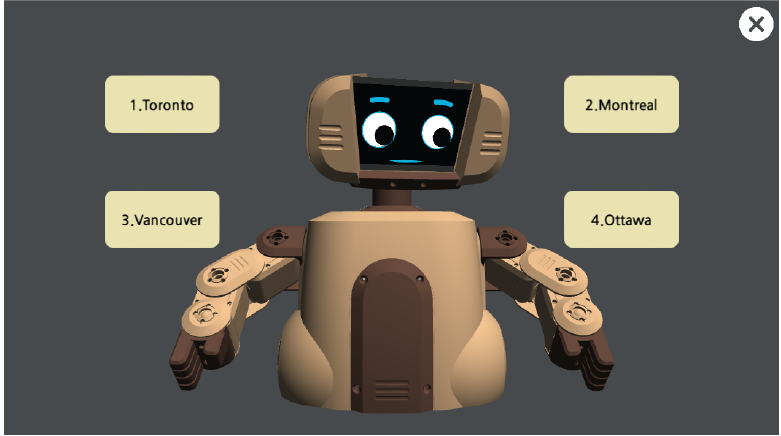
Figure 1. Our My Own Cognitive Communication Agent (MOCCA) simulator expressing a quick social cue to give a hint to the user.